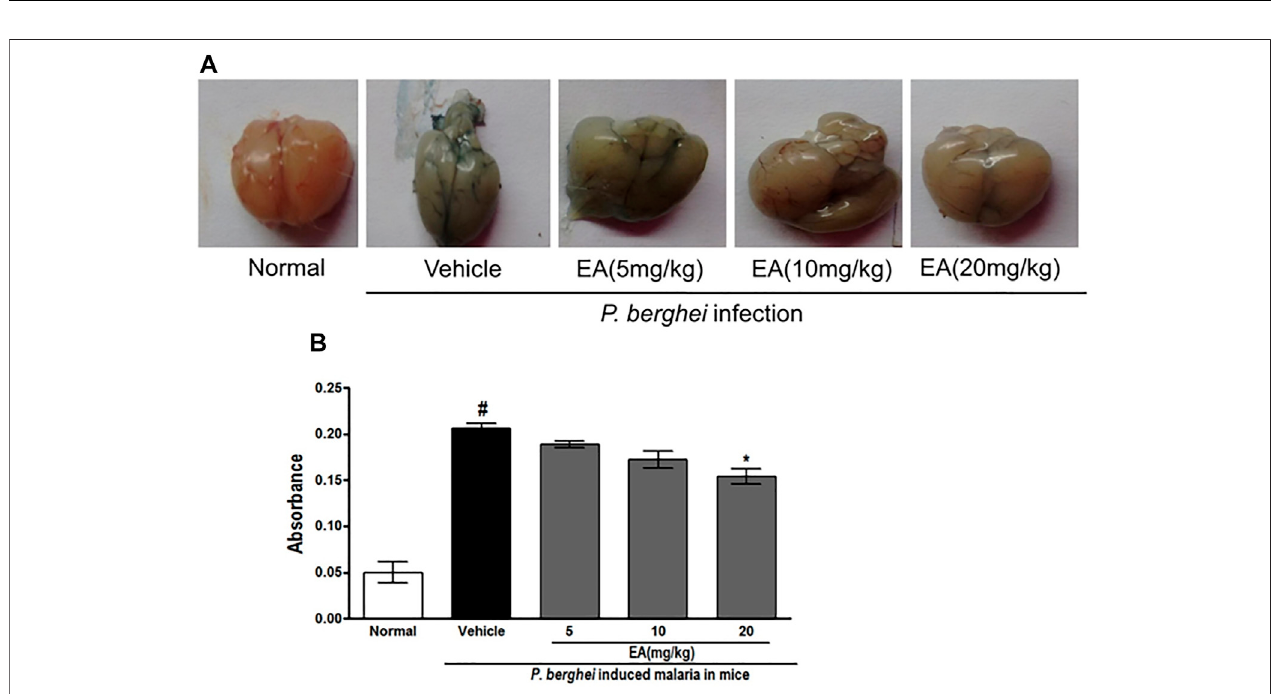
FIGURE 6 | Vascular permeability of brains was assessed by Evans Blue injection on peak day of parasitaemia (A) Vascular leakage was assessed by the blue discoloration of the brain tissue of the various treated groups (B) Quanti fi cation of Evans Blue extravasation in formamide, absorbance was measured at 620 nm; n (cid:1) 3. P < 0.05; #Normal vs vehicle treated; *Vehicle vs treatment.